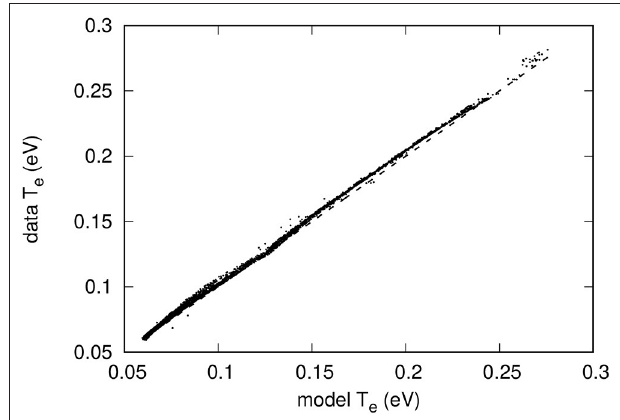
FIGURE 10 | Comparison between model-predicted and actual temperatures from the validation data set. The neural network used here was trained with 100 randomly selected characteristics. The dashed line corresponds to a perfect correlation between the two temperatures.